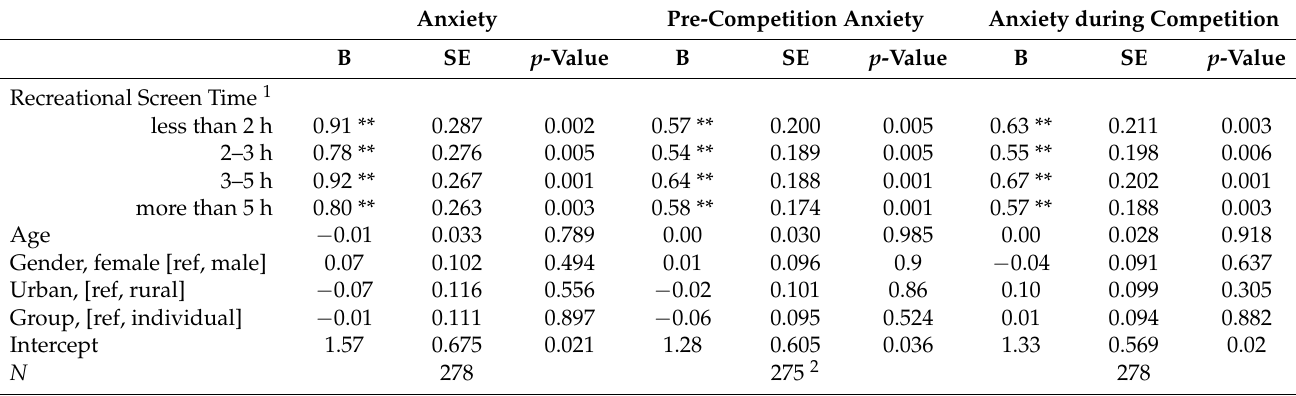
Table 3. Regression results on anxiety levels and recreational screen time among college